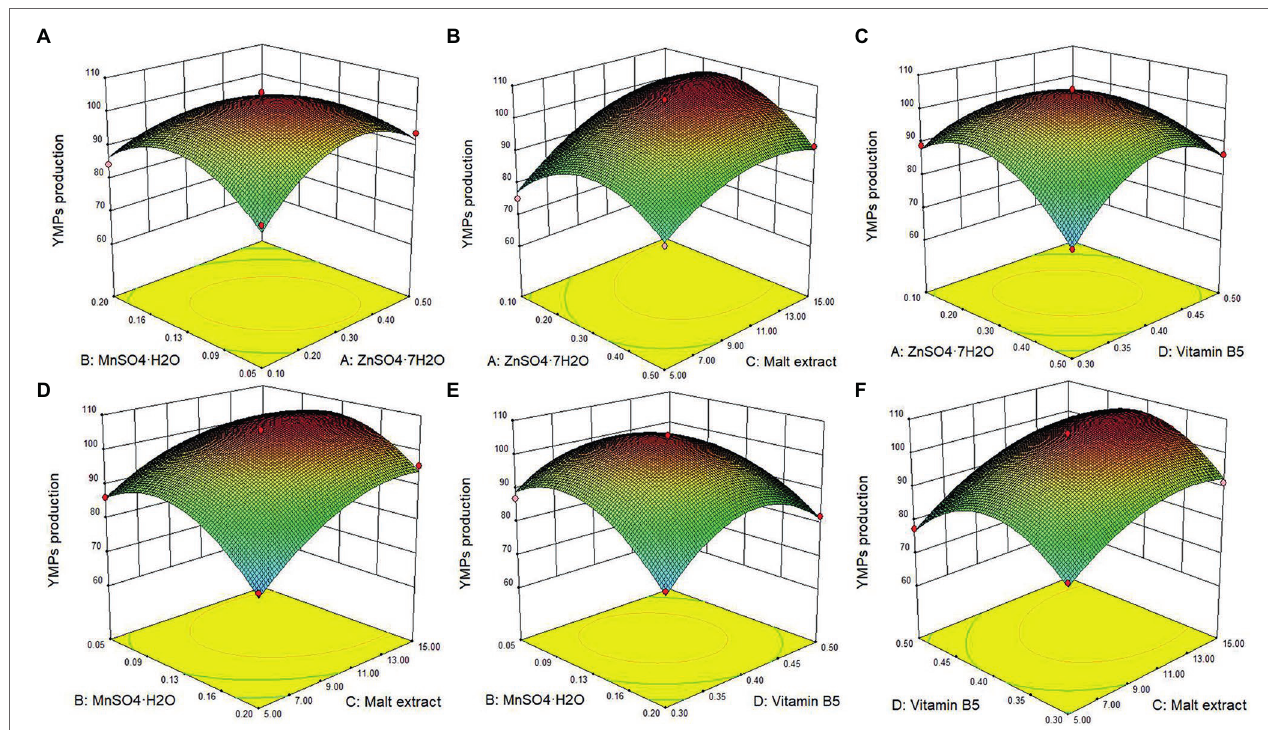
FIGURE 3 | Response surface plot of the effect of the interaction of ZnSO4•7H2O, MnSO4•H2O, malt extract, and vitamin B5 on the YMPs production in submerged fermentation by mutant strain M. purpureus H14. Effect of ZnSO4•7H2O and MnSO4•H2O (A) , effect of ZnSO4•7H2O and malt extract (B) , effect of ZnSO4•7H2O and vitamin B5 (C) , effect of MnSO4•H2O and malt extract (D) , effect of MnSO4•H2O and vitamin B5 (E) , and effect of malt extract and vitamin B5 (F)